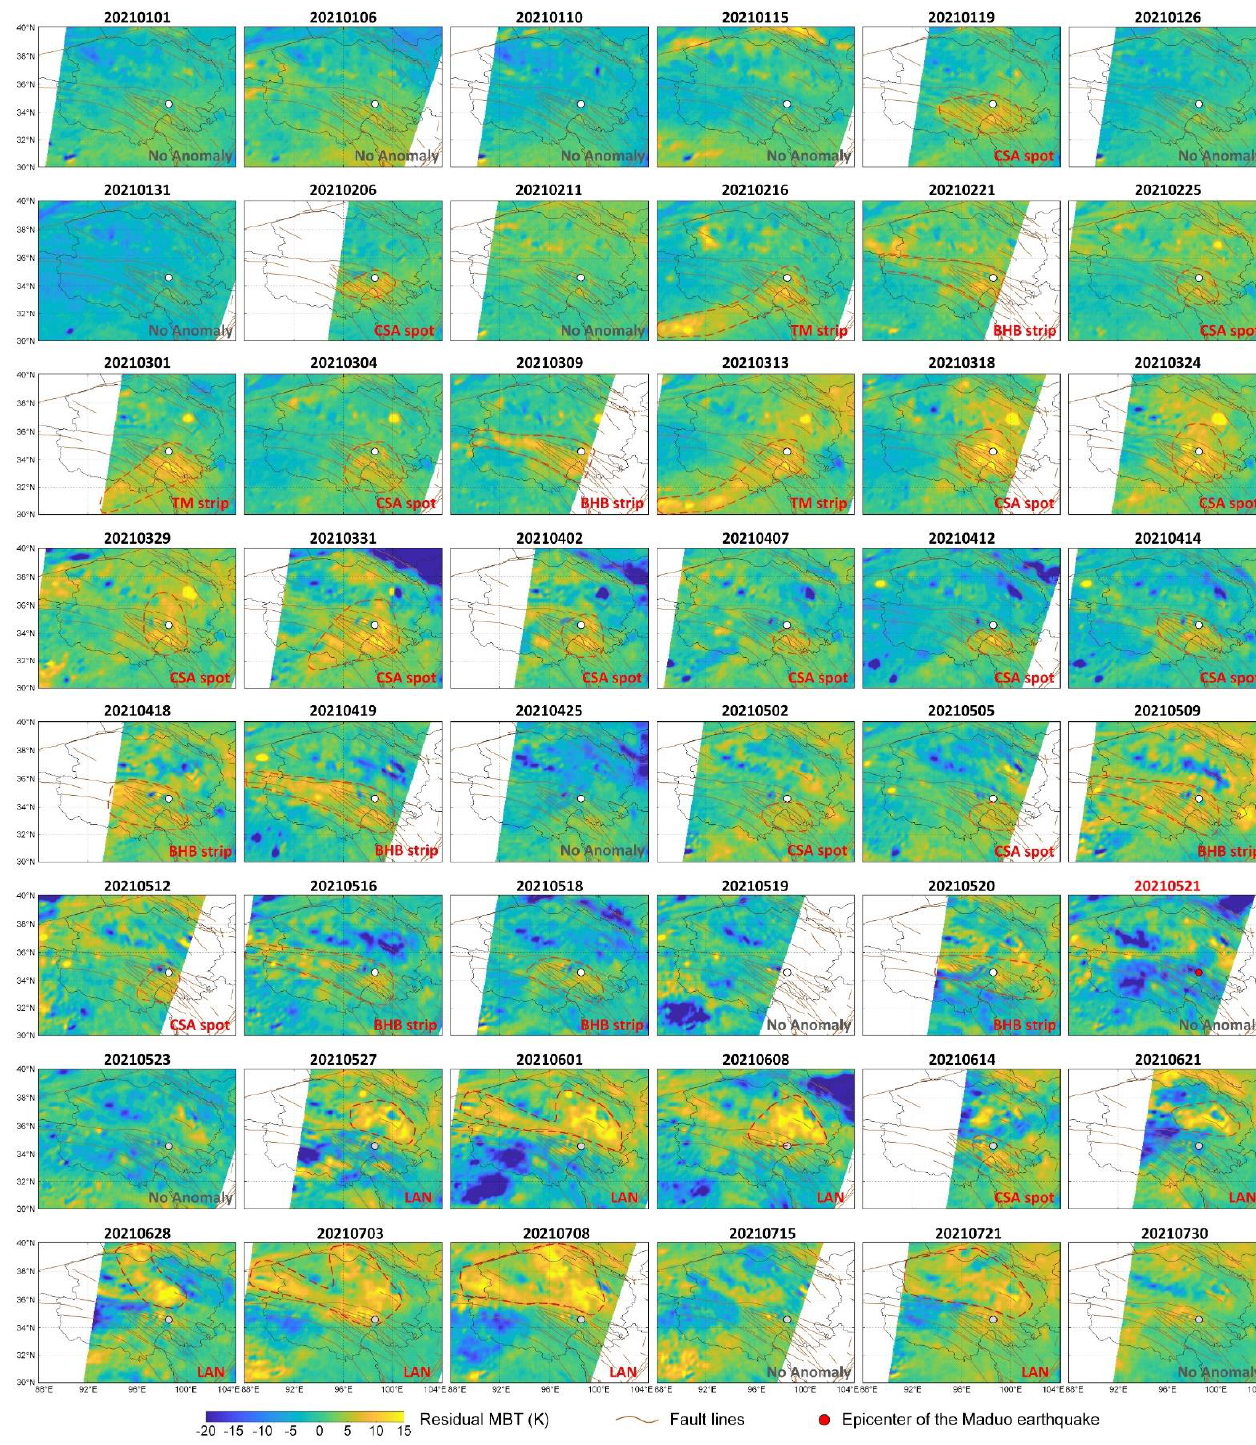
Figure 4. The retrieved MBT residuals (10.65 GHz at H polarization) in the study area from January to July, 2021. The circle dots mark the epicenter of the Maduo earthquake on 21 May 2021, with white, red, and gray color for the days before shock, on shock, and after shock, respectively. The text at the lower right corner of each subgraph indicates the type of residuals occurred on the